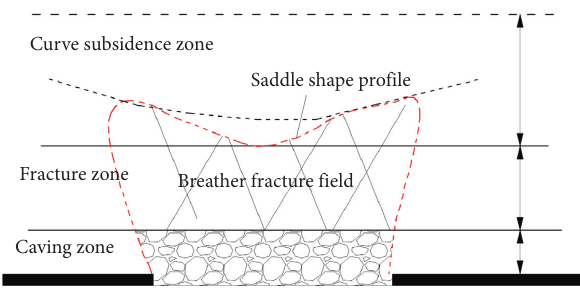
Figure 1: Distribution of saddle shape profile.